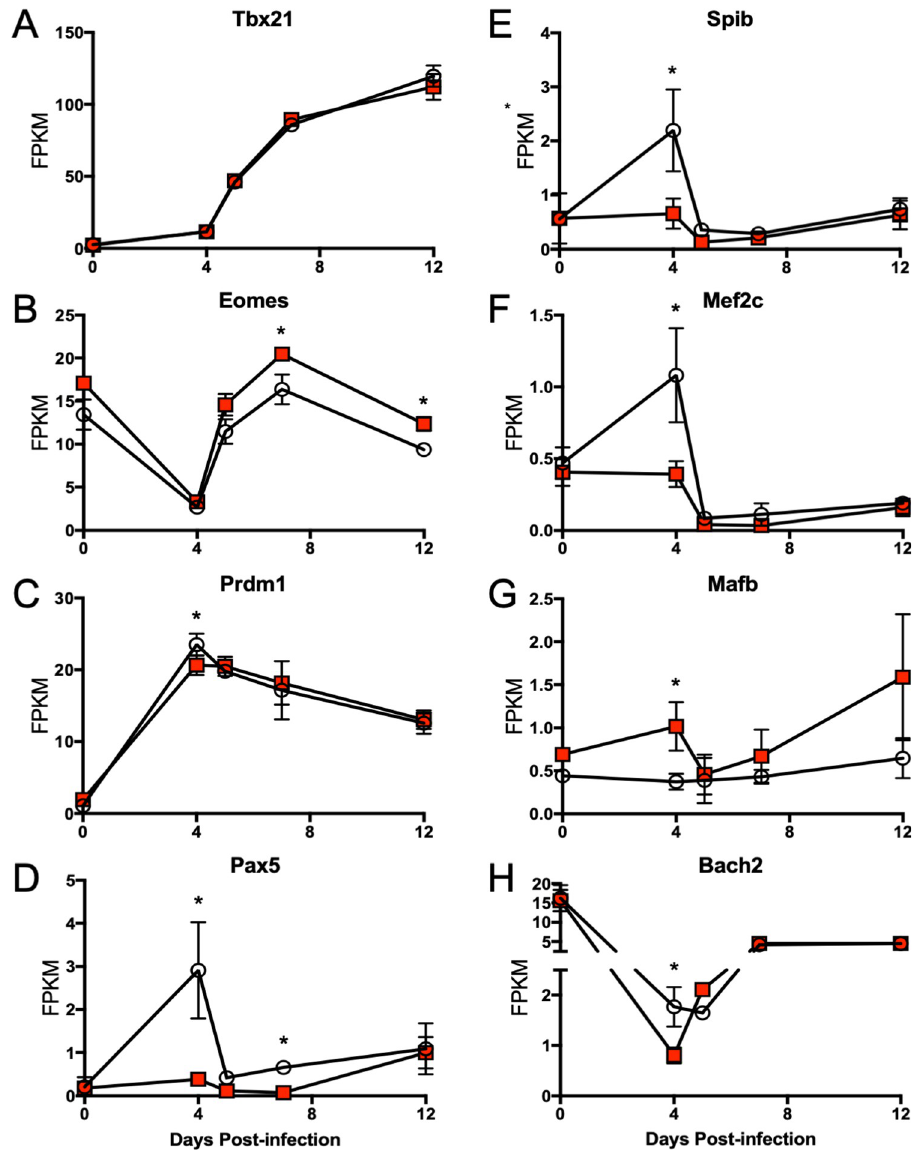
Fig 6. Select transcription factor expression regulated by the ADRB2. Gene expression data are derived from the RNASeq analysis described in Fig 3. Normalized mean (+/- SD) FPKM values for specific transcription factors are displayed for WT (open circles) and Adrb2 -/- (red squares) CD8 + T cells isolated at the indicated time points of infection. (A) Tbx21 , (B) Eomes , (C) Prdm1 , (D) Pax5 , (E) Spib , (F) Mef2c , (G) Mafb , (H) Bach2